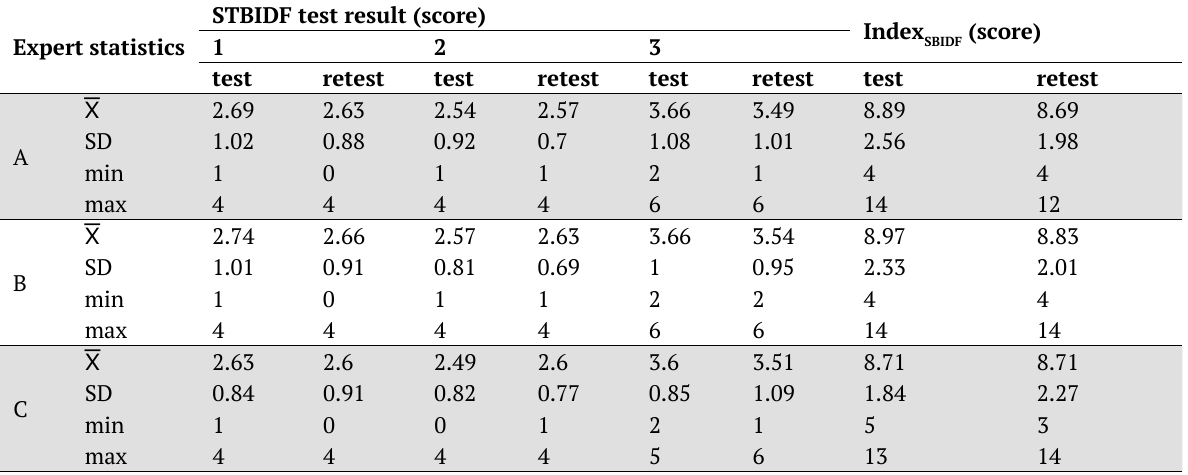
Table 2. Differences in mean Index